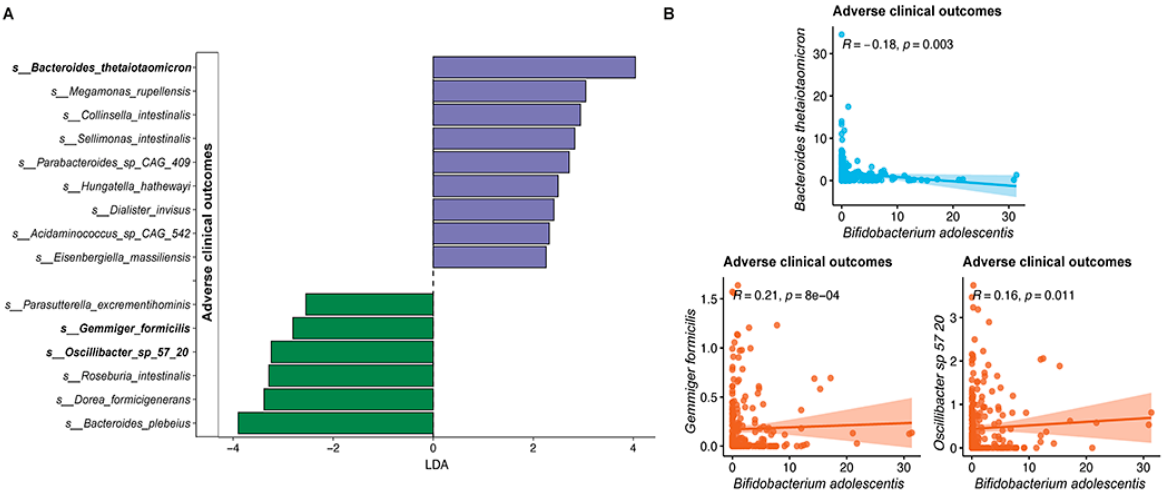
Figure 6. ( A ) Differential species between subjects with (n = 20) or without any adverse health outcomes (n = 238) at 3 months after the second dose of vaccination. Differentially abundant species groups were identified using the linear discriminant analysis effect size (LEfSe) (linear discriminant analysis (LDA) score > 2, and p < 0.05). Purple colour, species enriched in subjects with adverse health outcomes; green colour, species depleted in subjects with adverse health outcomes. ( B ) Correlation between Bifidobacterium adolescentis with species associated with adverse health outcomes. The correlation between the species abundance was analyzed using Spearman’s correlation tests.